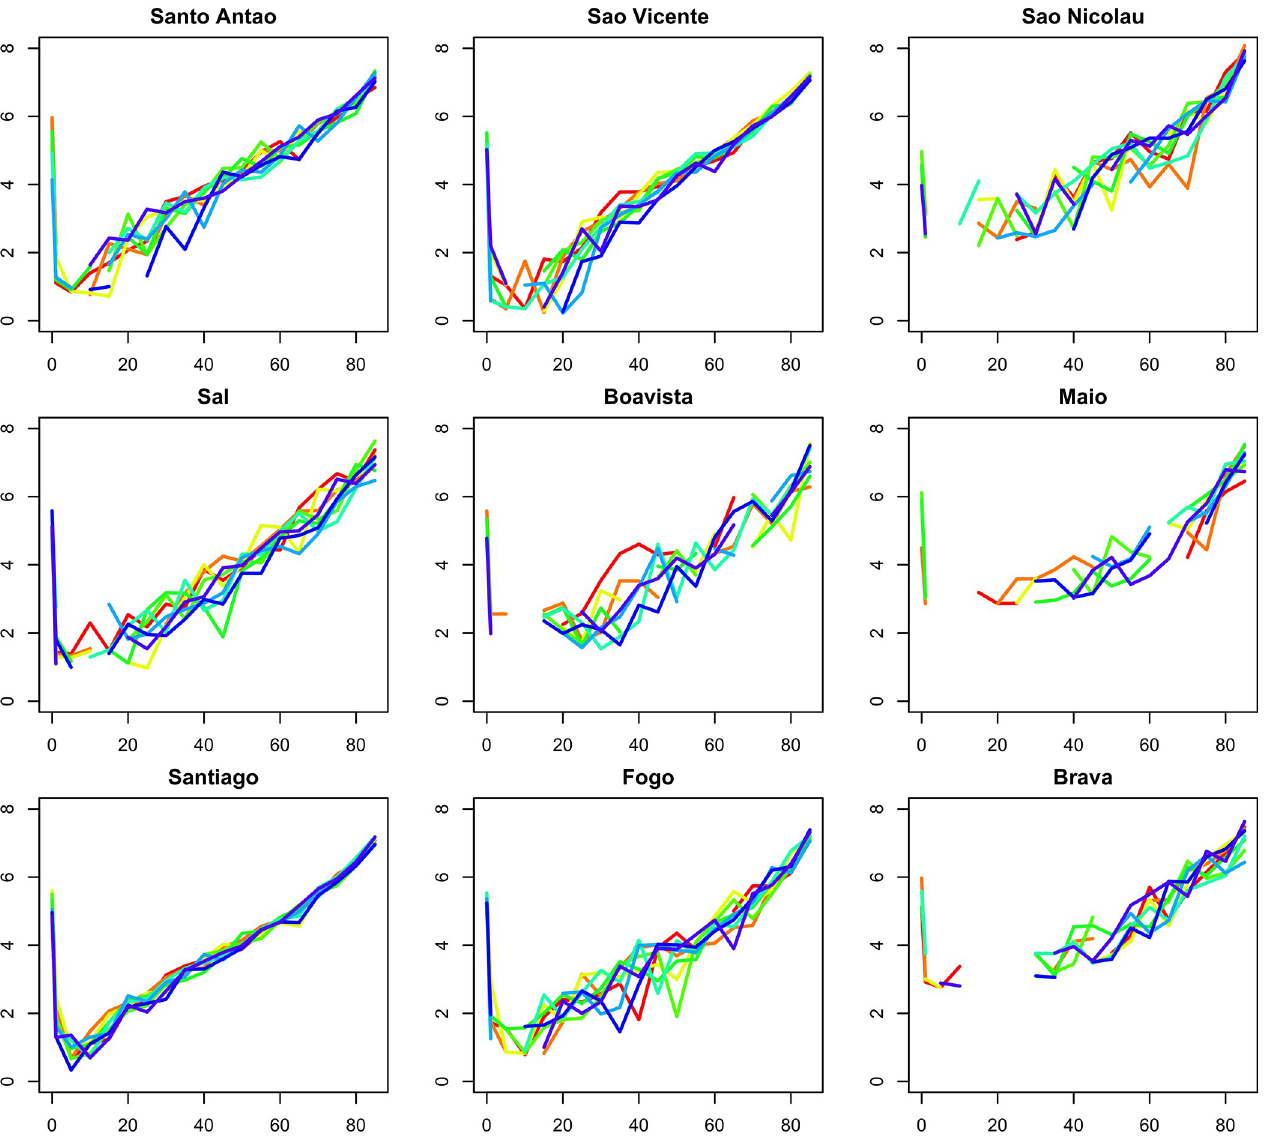
Fig 2. Graphic evolution of specific annual mortality (2010 to 2018) by island and